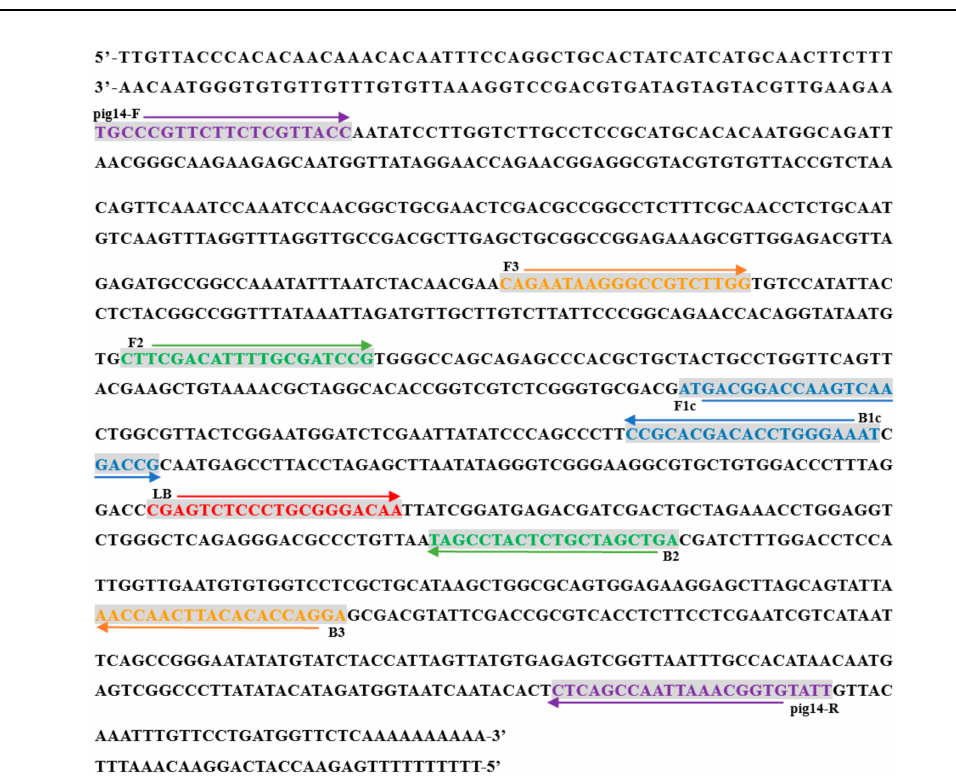
Figure 1. Sequence and orientation of primers in gene pig 14 (GenBank: AJ277800.1) used to develop LAMP and conventional PCR to detect P. graminea . Binding sites for outer primers in LAMP are highlighted in yellow, inner primers in green, and LB primers in blue. Binding sites for primers of conventional PCR are marked in